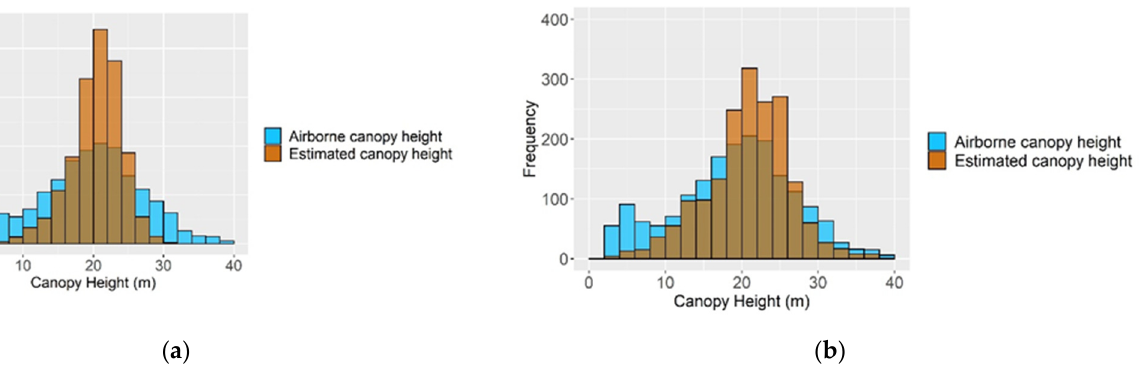
Figure 7. Histogram of airborne-lidar-derived and estimated canopy height at 30 m spatial resolution for ( a ) random forest and ( b ) regression kriging